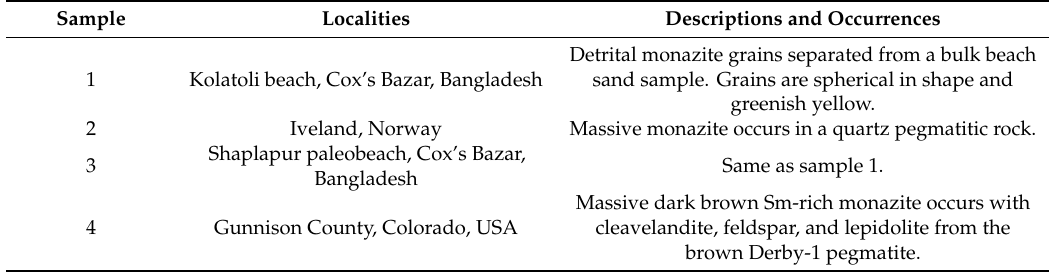
Table 1. Localities and description for the four monazite samples examined in this study.